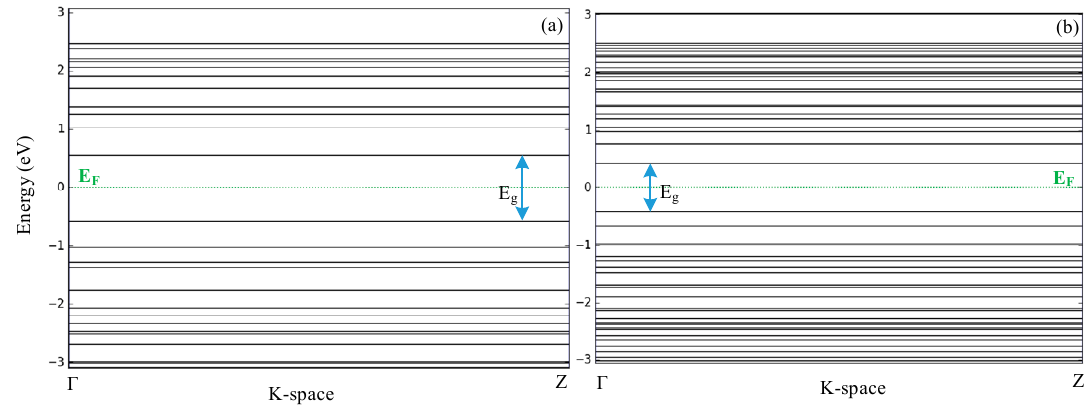
Figure 3. Energy levels of C 132 H 40 GQD via density functional theory (DFT) calculations: ( a ) monolayer and ( b ) bilayer systems. Table 1. Calculated electronic properties of the monolayer and bilayer graphene and GQDs via DFT and thermal DFT.